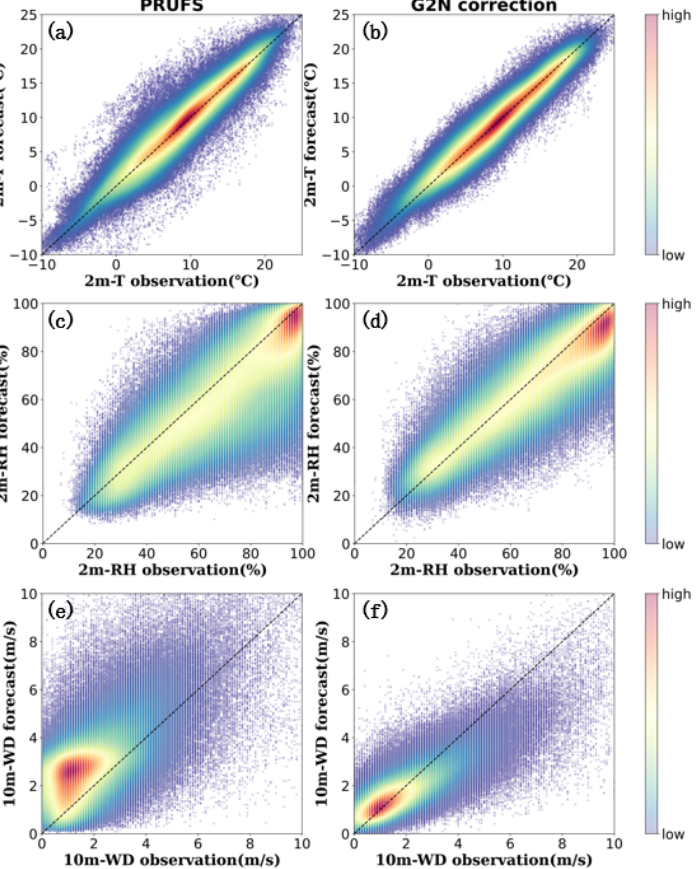
Figure 5. Density scatter plots of the forecast–observation pairs of the PRUFS forecasts ( 1st column ) and the G2N correction ( 2nd column ). The ( a , b ) 2 m temperature, ( c , d ) 2 m relative humidity, and ( e , f ) 10 m wind speed.